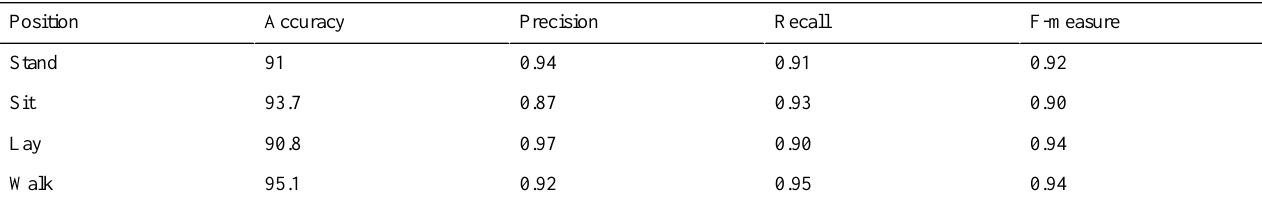
Table 2. Activity recognition: positioning.